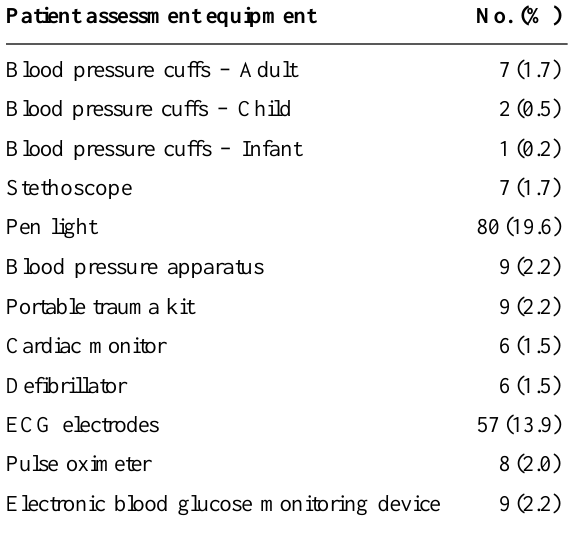
Table 3. Splinting equipment and dressing material available for a basic life support